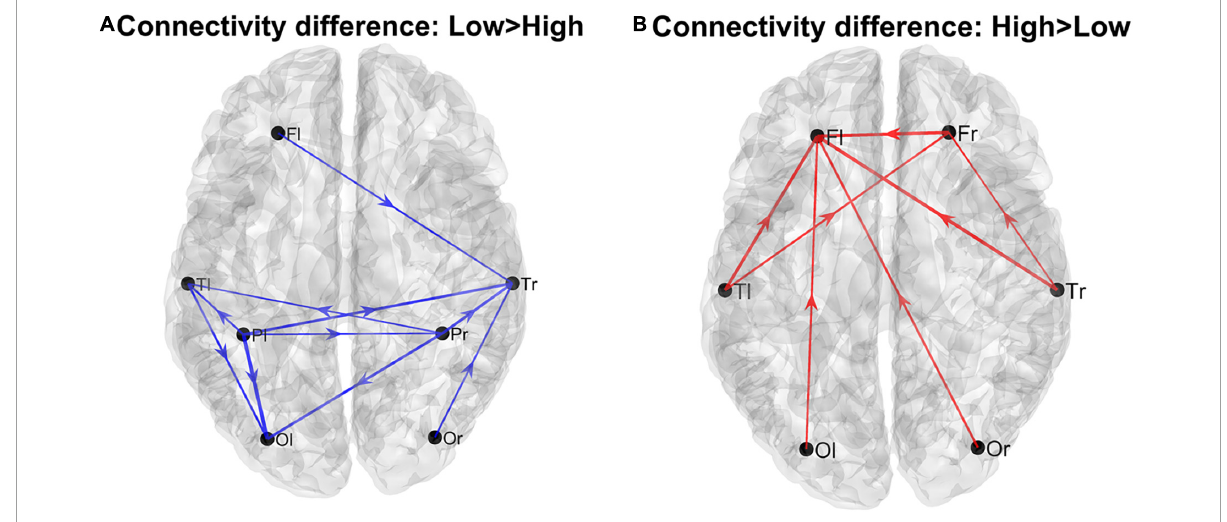
FIGURE1 Patterns of the main connection differences linking the four lobes (Frontal left and right, Fl and Fr, Temporal left and right, Tl and Tr, Parietal left and right, Pl and Pr, Occipital left and right, Ol and Or). The left panel (A) describes connections differences which are higher in the Low AQ score Group, while the right panel (B) describes connections differences which are higher in the High AQ score Group. Only connections differences with | t | > 1 (student t -test) are